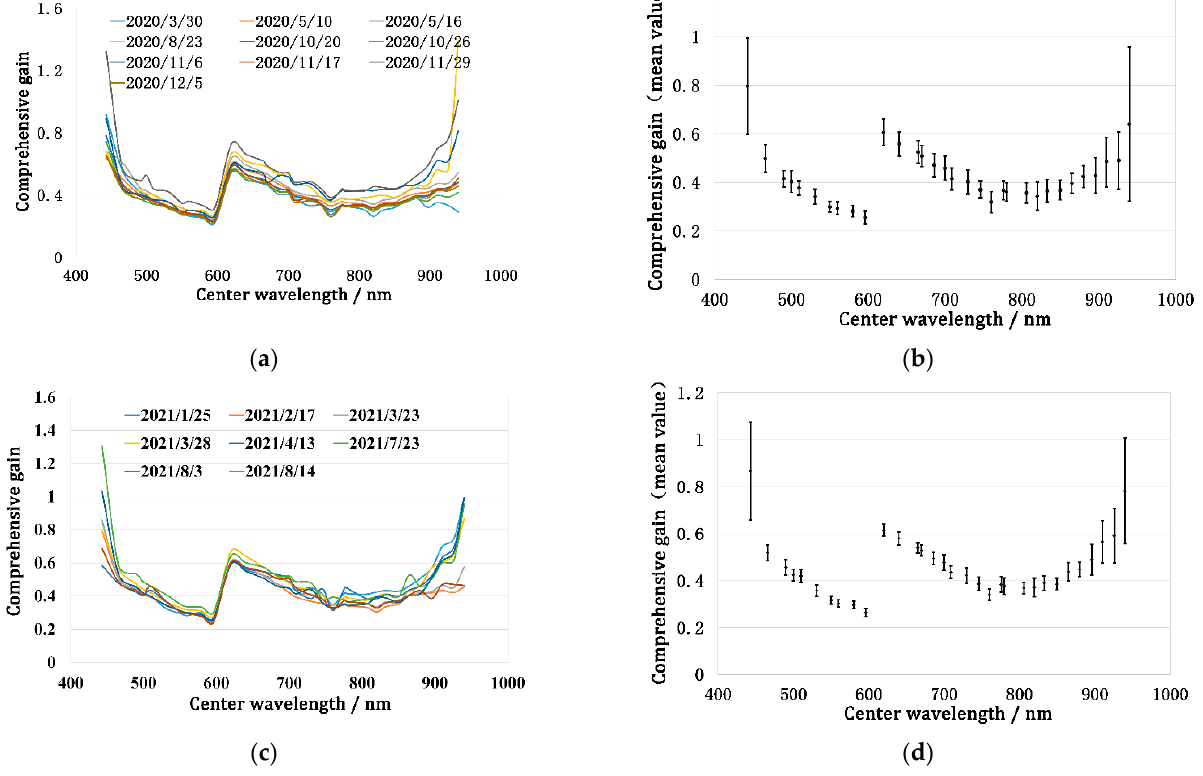
Figure 11. Calibration results for OHS-F CMOS3. ( a ) Description of comprehensive gains in 2020; ( b ) description of averaged value and SD of comprehensive gains in 2020; ( c ) description of comprehensive gains in 2021; ( d ) description of averaged value and SD of comprehensive gains in 2021.